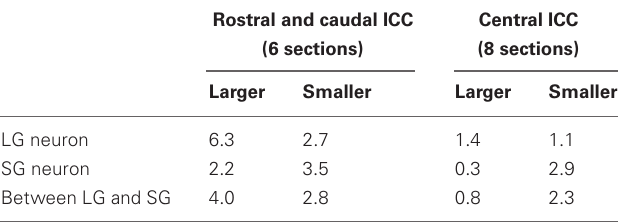
Table 3 | Mean number of points detecting significance in L functions. Rostral and caudal ICC